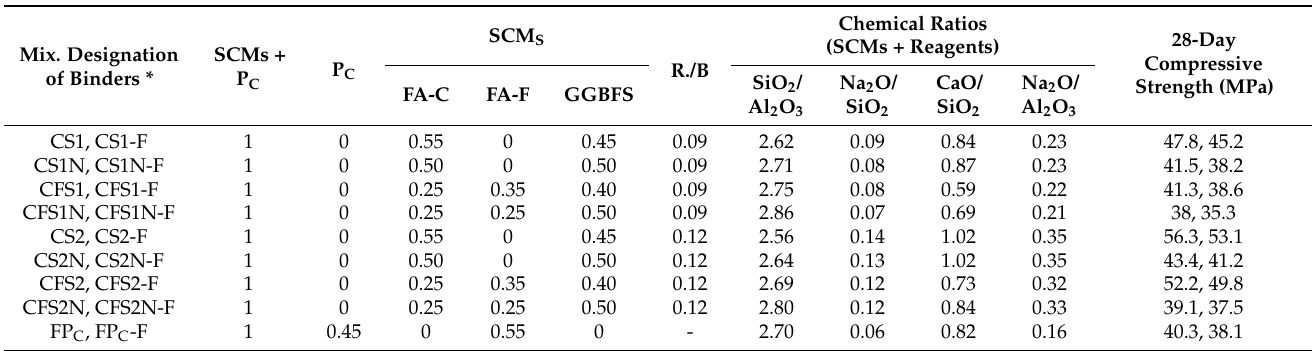
Table 2. Mix proportions for one-part binary and ternary binders with and without